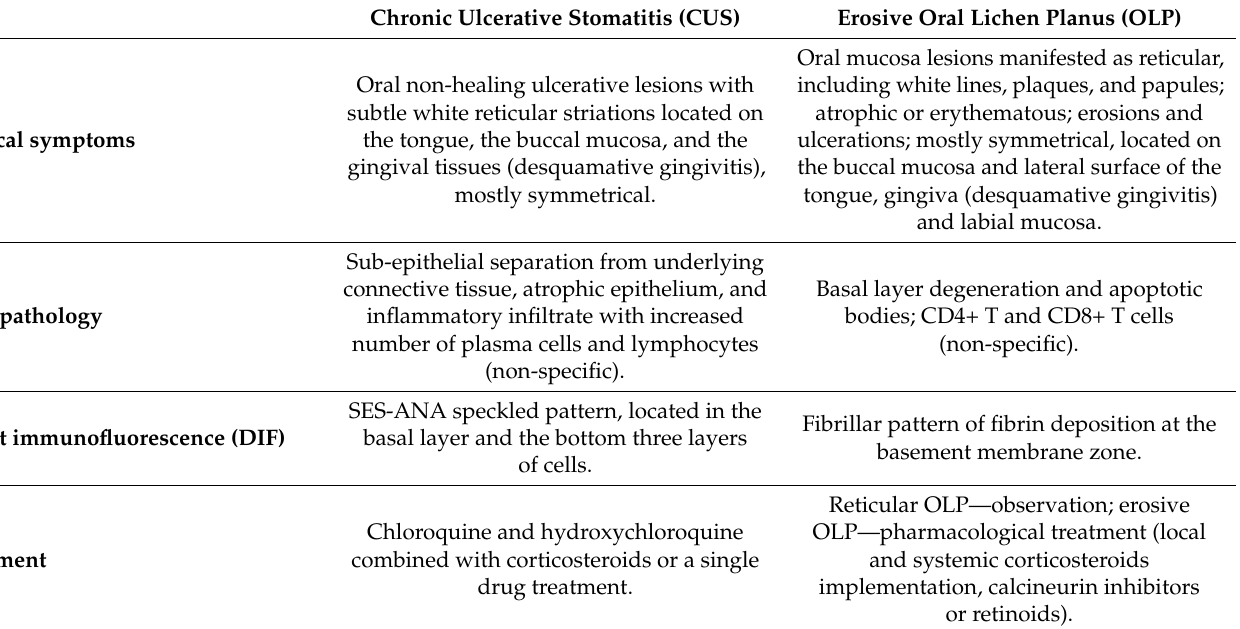
Table 2. Differentiation of CUS and erosive